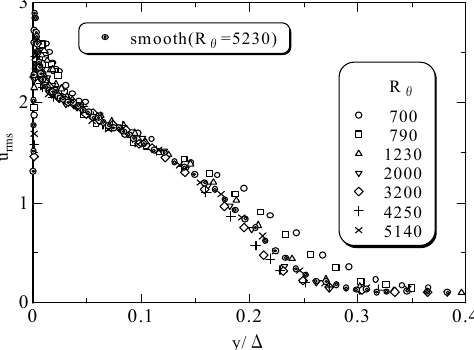
Fig.9 Similarity of the streamwise turbulent intensity profile normalized with the similarity variables.